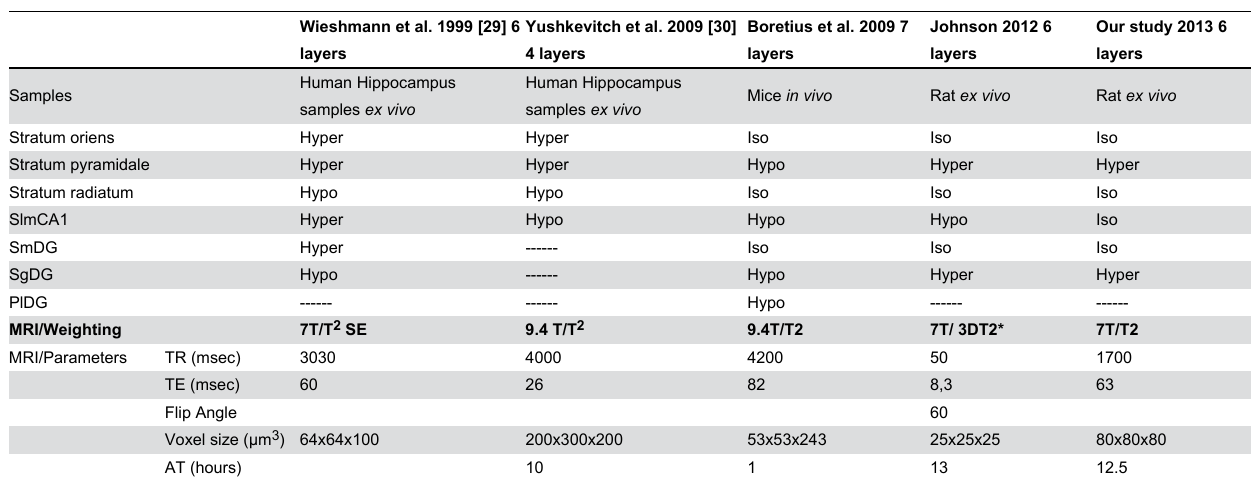
Table 5. Review of hippocampus MRI signals.